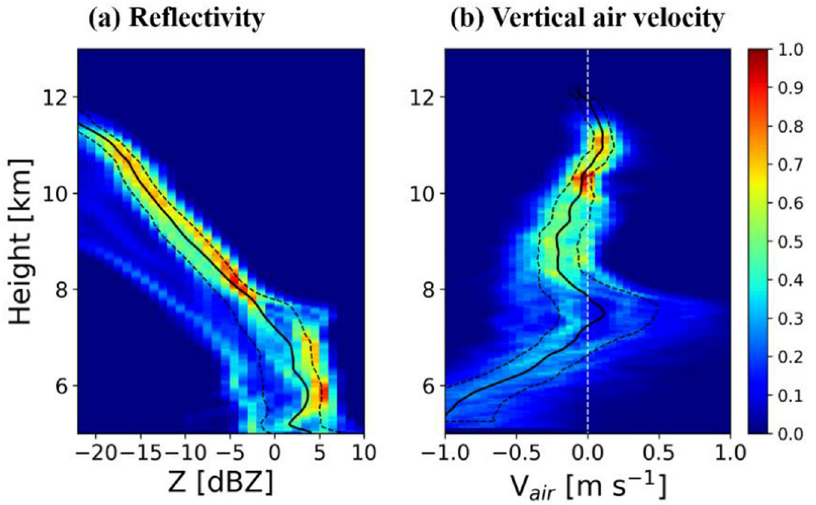
Figure 17. CFADs of ( a ) observed Z and ( b ) retrieved V air of a case at 04 UTC on 18 June 2013. The median and quantiles (25% and 75%) are shown in the solid and dashed lines.